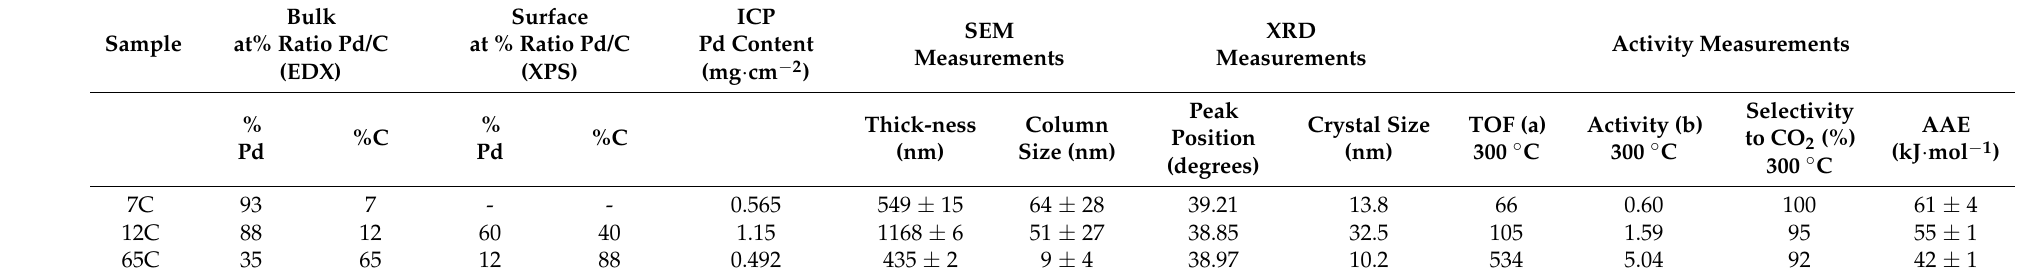
Table 2. Catalysts’